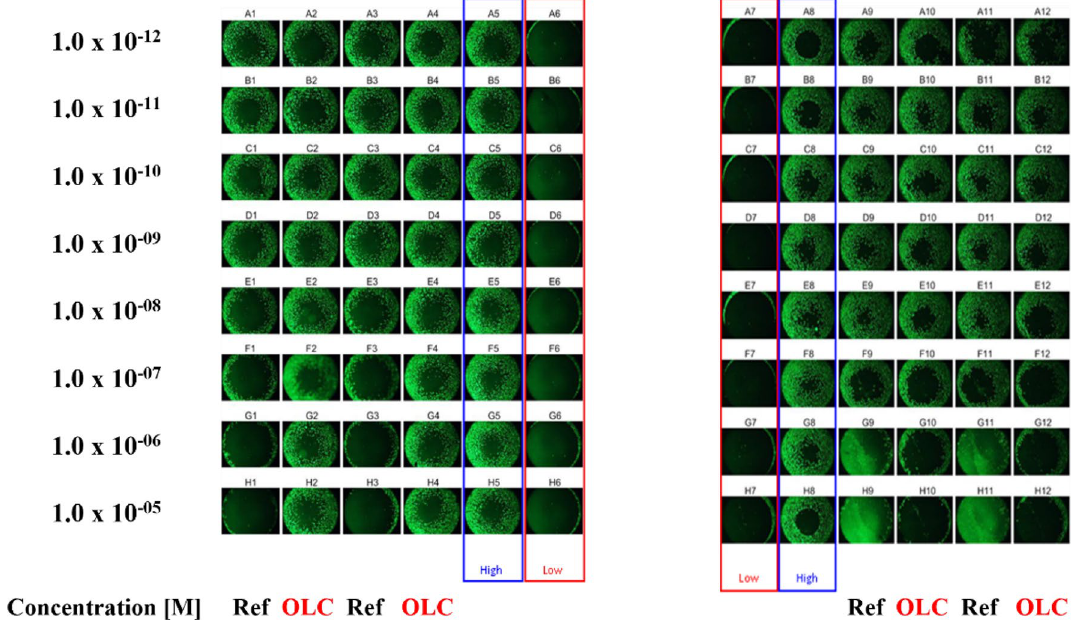
Fig. 2 Detection of cell migration with cell-permeable dye. Calcein-AM labeled LN229 (left) and T98G (right) cells in the migration area of the 96 well ORIS plate were photographed with a magnification of 40 × using a Nicon Eclipse TE2000-U fluorescence microscope and the software NIS Elements 3.0. OLC is Ouabain and Ref is SKI-606. Median value of solvent control (DMSO) was set to 100% (high control – blue box) and median value of zero controls (with stopper inserts) was set to 0% (low control – red box). (Conc: from 1 × 10 –5 M at bottom to 1 × 10 –12 M at The LN229 cells did not reveal any change in their plasma cell membrane potential (Fig. 3a). In contrast, the T98G cell line responded significantly (p < 0.01) with a clear depolarization of the plasma cell membrane after 4 h treatment with Ouabain at concentrations (IC = 2.72 × 10 –7 M) which are in range of inhibiting the NKA (Fig. 3b). Interestingly, a 50 significant inverse correlation (R 2 = 0.95, p = 0.002) between plasma cell membrane potential and cell migration inhibi- tion was seen (Fig. 4).